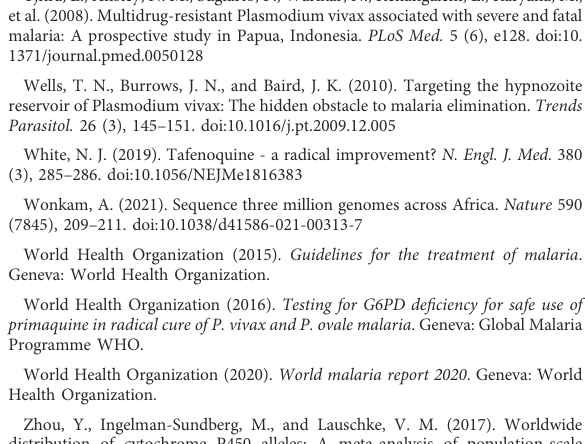
vivax: A round table discussion of the APMEN vivax working group. Malar. J. 16 (1), 141. doi:10.1186/s12936-017-1784-1 Tjitra, E., Anstey, N. M., Sugiarto, P., Warikar, N., Kenangalem, E., Karyana, M., etal.(2008).Multidrug-resistant Plasmodiumvivaxassociated withsevere andfatal malaria: A prospective study in Papua, Indonesia. PLoS Med. 5 (6), e128. doi:10. 1371/journal.pmed.0050128 Wells, T. N., Burrows, J. N., and Baird, J. K. (2010). Targeting the hypnozoite reservoir of Plasmodium vivax: The hidden obstacle to malaria elimination. Trends Parasitol. 26 (3), 145 – 151. doi:10.1016/j.pt.2009.12.005 White, N. J. (2019). Tafenoquine - a radical improvement? N. Engl. J. Med. 380 (3), 285 – 286. doi:10.1056/NEJMe1816383 Wonkam, A. (2021). Sequence three million genomes across Africa. Nature 590 (7845), 209 – 211. doi:10.1038/d41586-021-00313-7 World Health Organization (2015). Guidelines for the treatment of malaria . Geneva: World Health Organization. World Health Organization (2016). Testing for G6PD de fi ciency for safe use of primaquine in radical cure of P. vivax and P. ovale malaria . Geneva: Global Malaria Programme